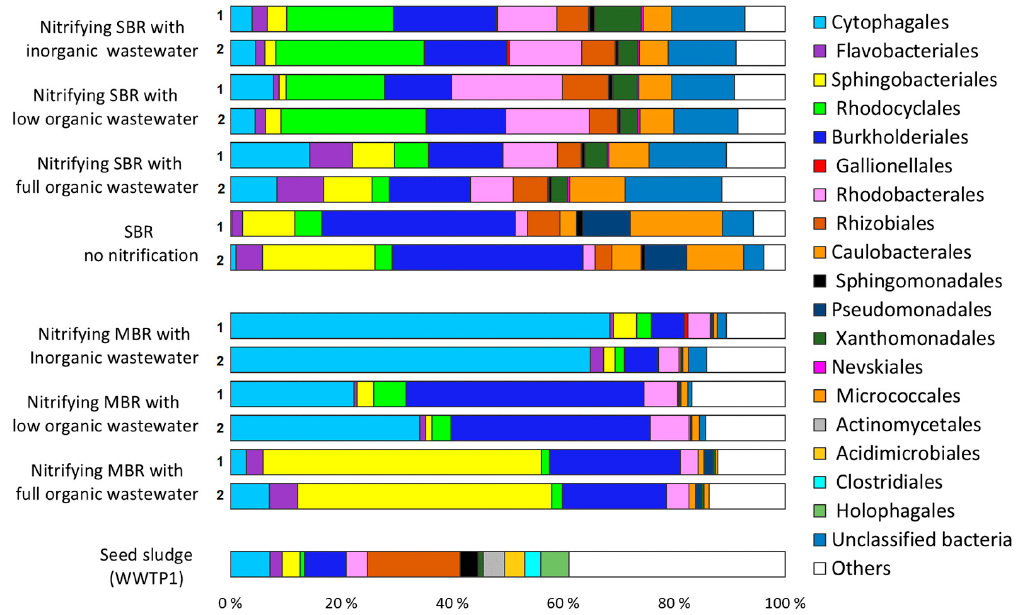
Figure 7. Relative abundance of dominant bacterial orders in pilot reactors during the experimental period.